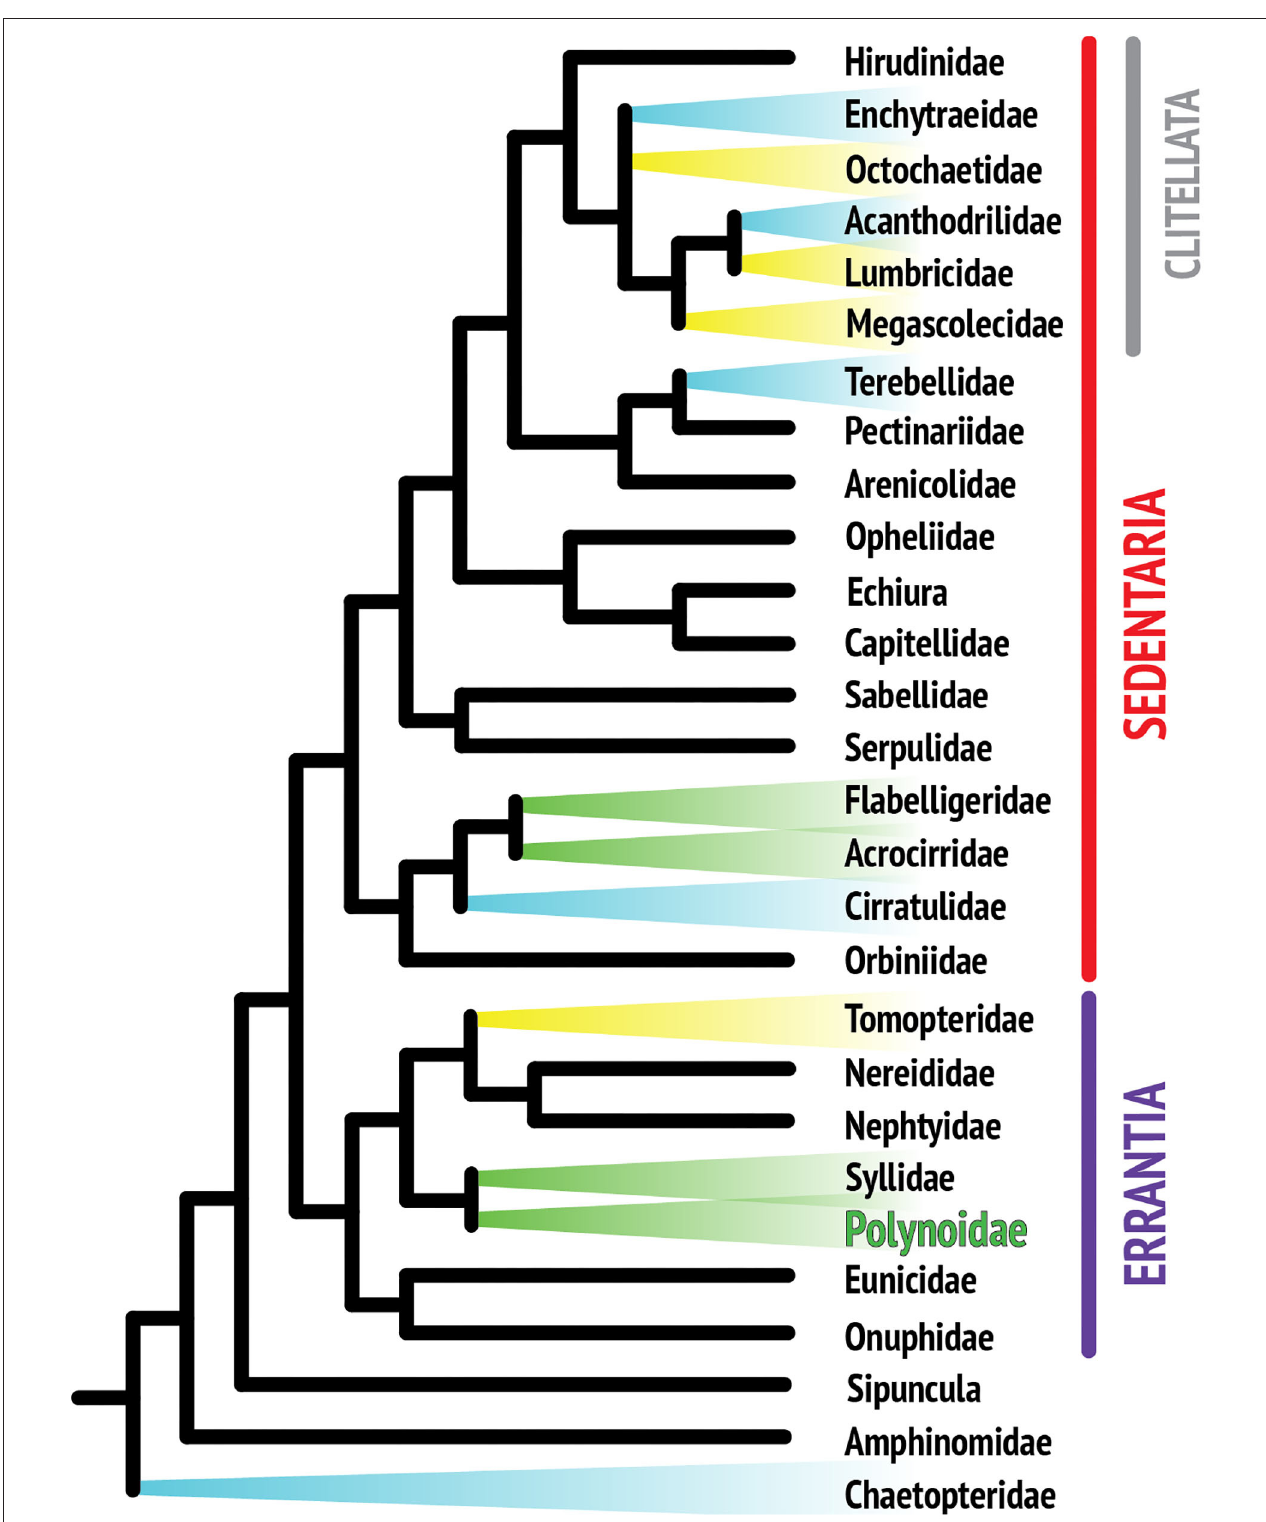
FIGURE 1 | Composite phylogenetic tree of annelid families based on recent phylogenetic and phylogenomic analyses. Note that not all annelid families are represented, as the position of many taxa still remains unresolved. The monophyletic class Clitellata is nested within the paraphyletic polychaetes. Branches highlighted in color indicate families with reported bioluminescent representatives. Colors are indicative of the general color emitted by species within that family.